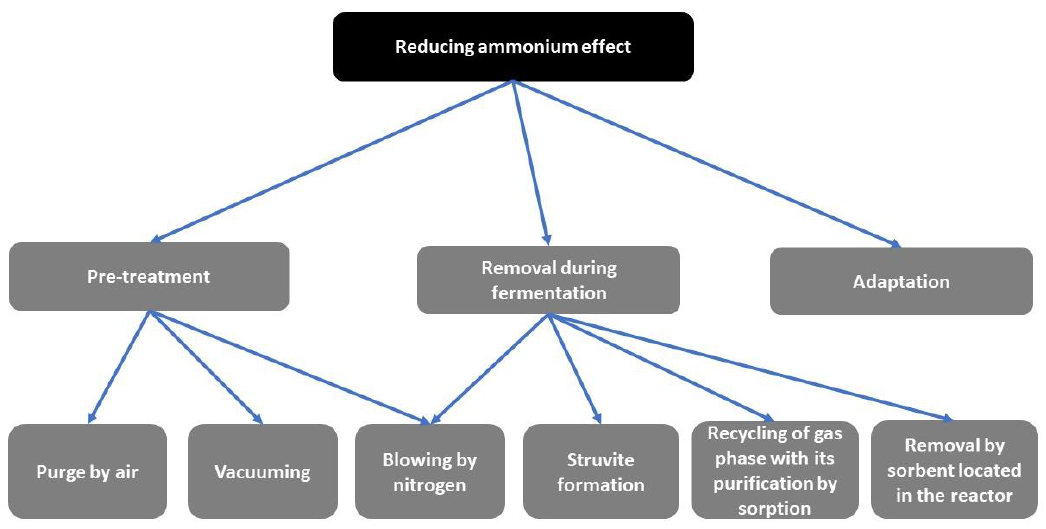
Figure 11. Approaches to the effect of ammonium reducing during dry AD.